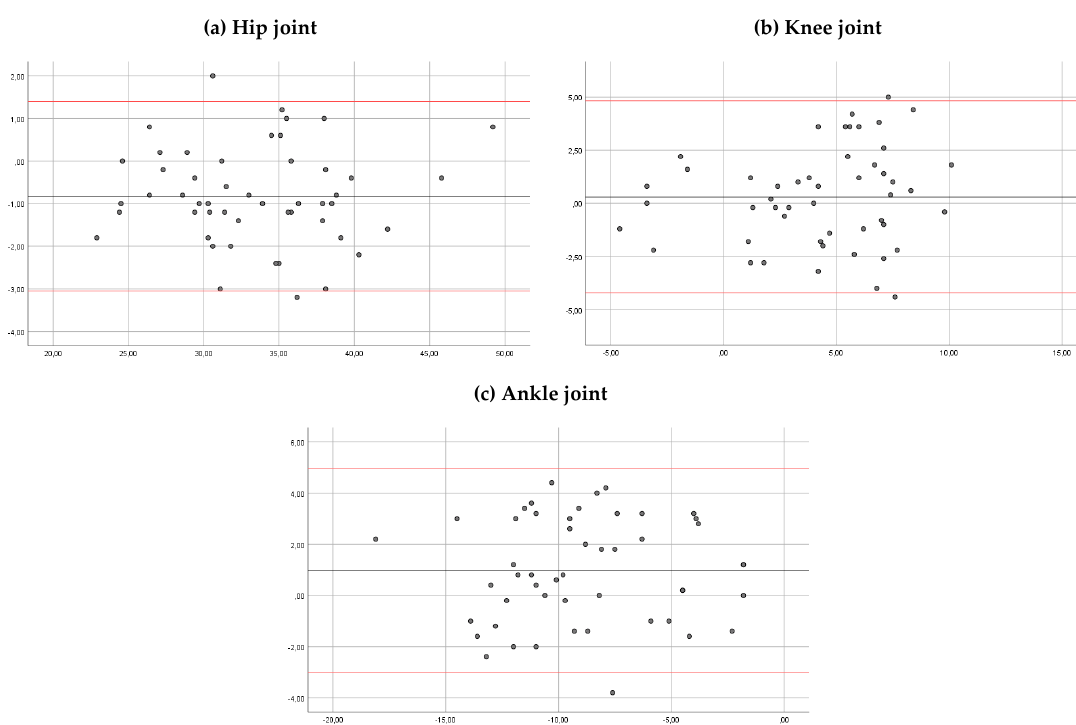
Figure 5. Bland–Altman plots comparing results between sessions of measurements (for observer 2) for the hip ankles ( a ), knee angles ( b ) and ankle angles ( c ). Bias (black line) and limits of agreement (red lines) are shown for each parameter. The mean score is plotted on the x -axis, and the difference between sessions (mean of the differences) is plotted on the y -axis (mean difference ± 1.96 SD). The ICC for the inter-rater reliability was >0.90 for the hip, the knee and the ankle joints in both observers (Table 2). The mean of the differences was 0.8, 0.09 and 0.48 degrees, respectively. In Bland– Altman plots, the limit of agreement for the hip, knee and ankle angles was 1.40 to − 3.05, 2.09 to − 1.90, and 3.16 to − 2.18 degrees, respectively (Figure 6). Table 2. Inter-rater reliability of the Kinovea parameters. Angles (Degrees)